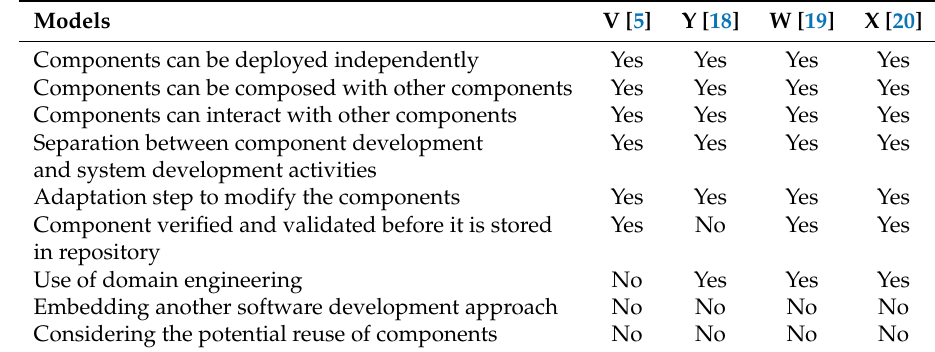
Table 1. Analysis of existing component-based process